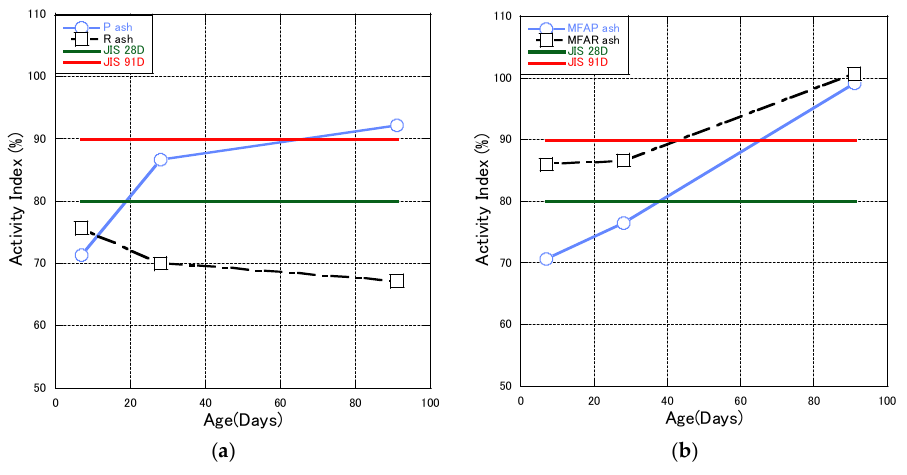
Figure 6. The activity indices of fly ashes.